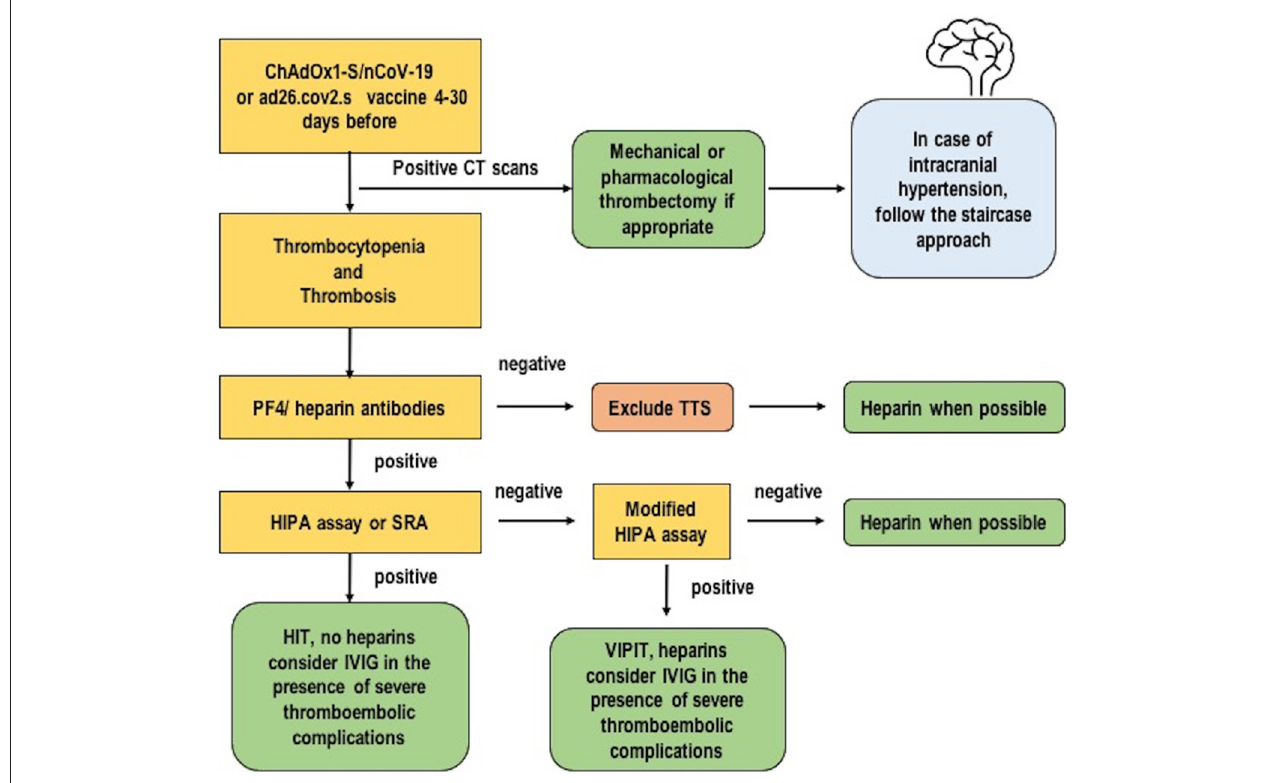
FIGURE 3 | A possible diagnostic and therapeutic algorithm for thrombosis with thrombocytopenia syndrome. Modified from Oldenburg et al. (9).